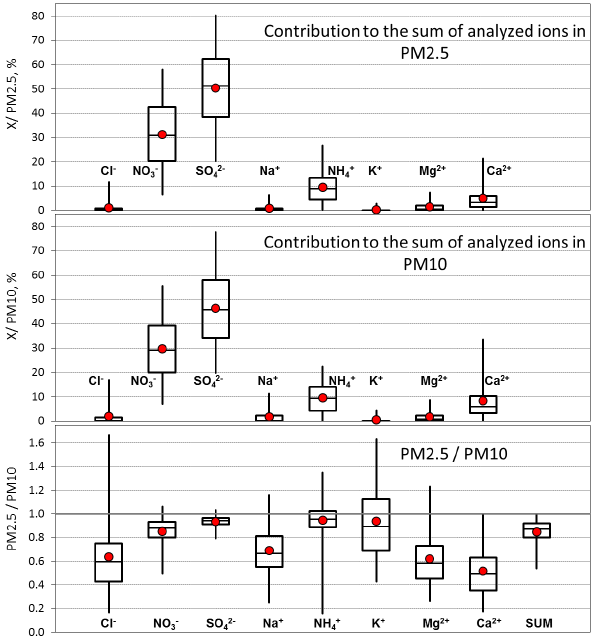
Fig. 4. Contributions of the major ions to their sum and the ratios of ion concentrations in two size ranges PM 10 ( D p < 10µm) and PM 2 . 5 ( D p < 2.5µm) in the period when both the PM 10 inlet and the PM 2 . 5 cyclone were in use. The box represents the 25th to 75th percentile range, the bars the 95 percent range (2.5th and 97.5th percentiles), the horizontal line the median and the red circle the averages of the hourly-averaged data.